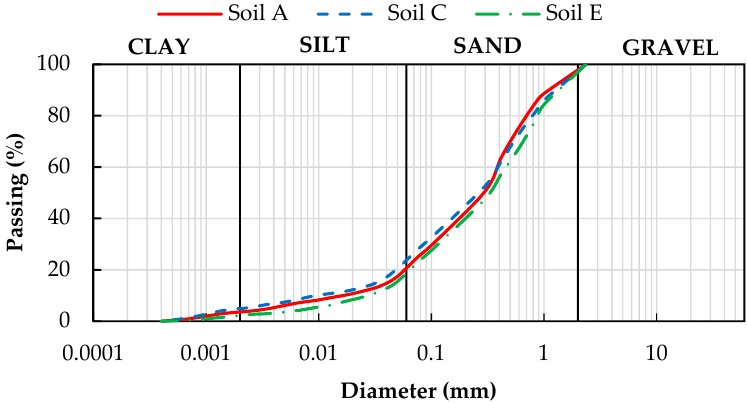
Figure 2. Particle size distribution curves of the three tested soils.